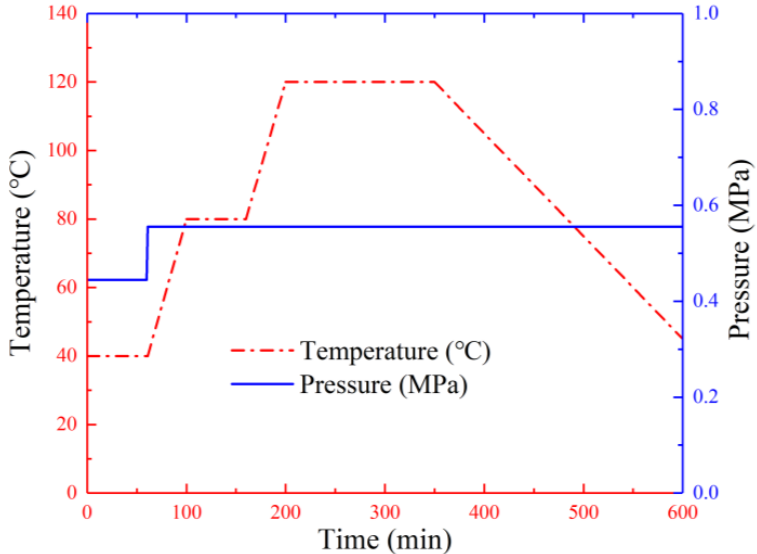
Figure 3. Curing procedure for the hybrid tubes. Table 1. Geometrical parameters of specimens in axial crushing test. Sample